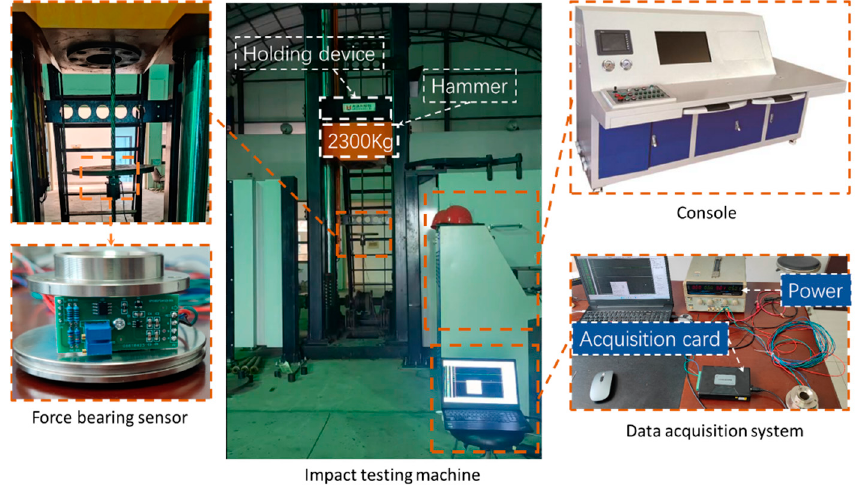
Figure 2. Hammer impact test system.